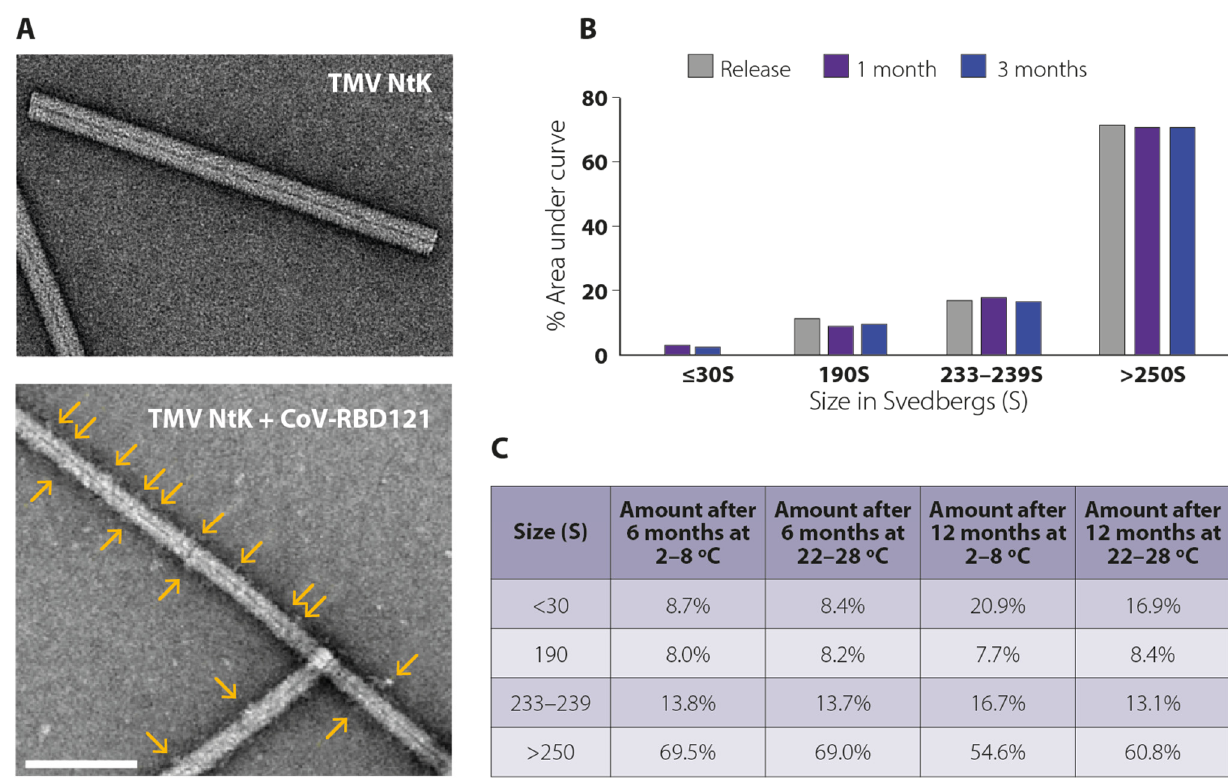
Figure 2. Physical properties of CoV-RBD121-NP. ( A ) Transmission electron microscopy of TMV Ntk virions and CoV- RBD121-NP (the virions after conjugation with the antigen). Yellow arrows indicate positions of conjugated antigen). Scale bar = 200 nm. ( B ) Size distribution of CoV-RBD121-NP at release and 1 and 3 months after storage at 2–8 °C. Distribution was calculated based on area under the curve (AUC) after analytical centrifugation. ( C ) Size distribution of CoV-RBD121-NP at 6 or 12 months after storage at 2–8 °C or 22–28 °C. Amount is shown as percentage of total based AUC analysis after ultracentrifugation.